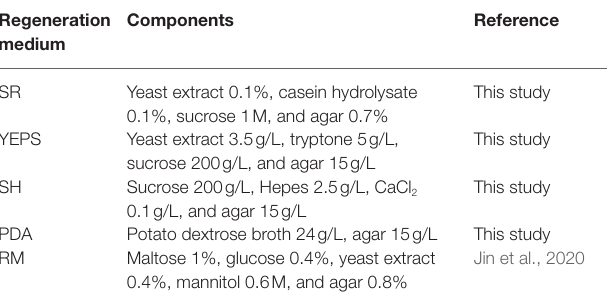
TABLE 2 | Components of strain D-1 regeneration